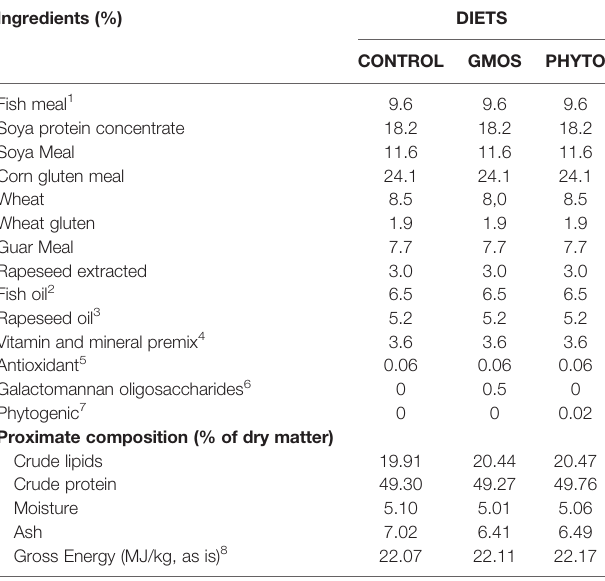
TABLE 1 | Main ingredients and analyzed proximate composition of the